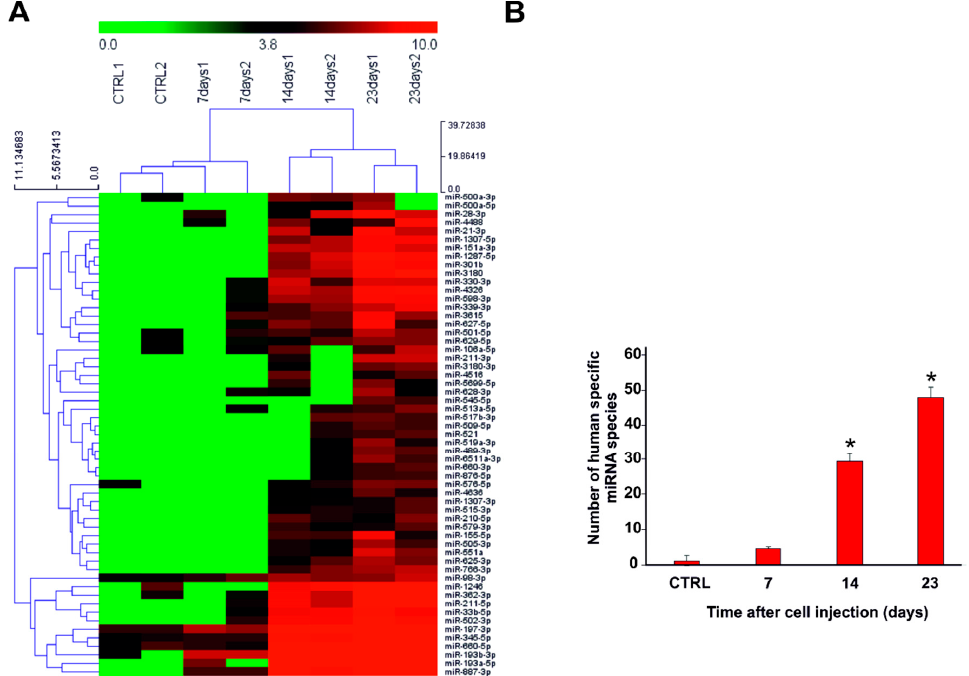
Figure 4. Hierarchical clustering analysis of the human-specific miRNAs released in the mouse total plasma. ( A ) Clustering analysis was performed as a function of the tumor growth in the brain. ( B ) Expression of the human-specific miRNAs released in the total plasma during the tumor growth at different time points after intracranial cell injection. Unpaired-one-tailed student’s t test was used for statistical comparison between the different groups and the CTRL group (* = p < 0.05).